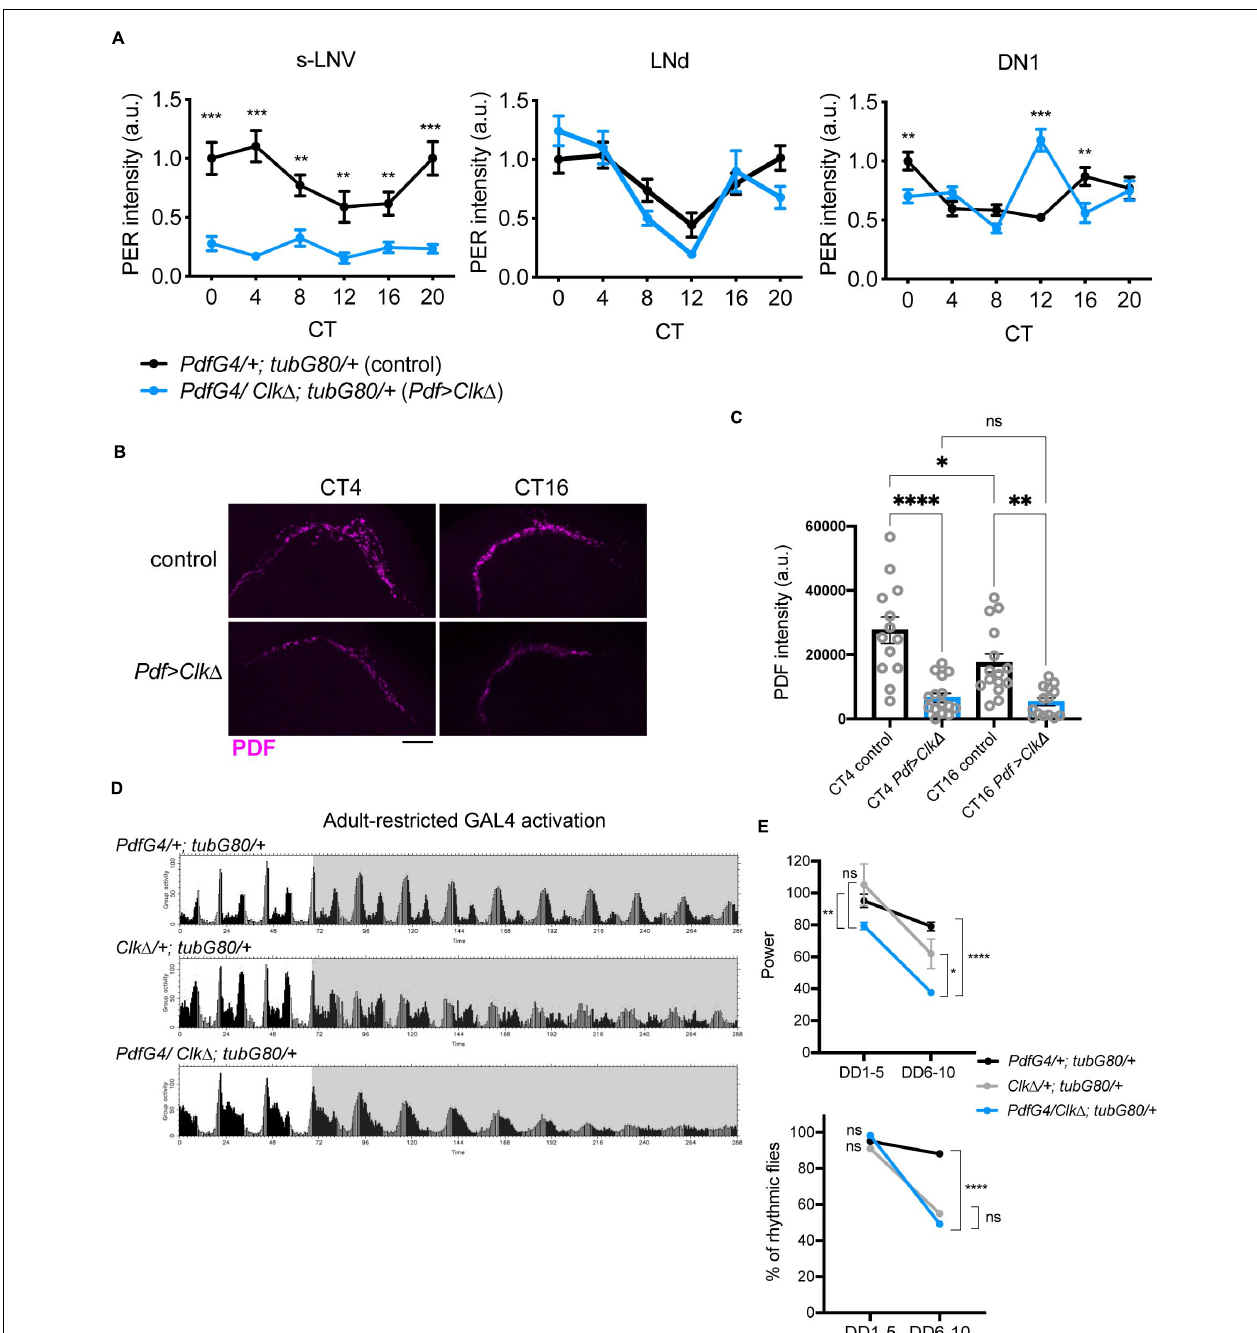
FIGURE 2 | Blocking M-oscillator clocks by conditional expression of CLK (cid:49) has little effects on free-running locomotor rhythms. UAS-Clk (cid:49) was expressed in the LNvs only during adulthood with Pdf-GAL4 , tub-GAL80 ts and a temperature shift from 18to 29 ◦ C. (A) The brains were stained for PER and PDF on DD3 and the levels of PER in the s-LNvs, DN1s and LNds were quantified. n = 20–27 hemispheres per group. ** p < 0.01, *** p < 0.001 by multiple unpaired t -test with Welch’s correction, comparing two genotypes at each timepoint. (B,C) PDF levels in the s-LNv dorsal terminals at two timepoints on DD3. Adult-restricted Clk (cid:49) in the LNvs significantly reduced PDF levels and disrupted its rhythm. Scale bar, 20 µ m. n = 12–15 per group. * p < 0.05, ** p < 0.01, and *** p < 0.00 by 2-way ANOVA with Sidak’s multiple comparison test. (D) Group average locomotor activities of the flies in LD (white background) and DD (gray background). (E) The power of rhythmicity and the percentage of rhythmic flies during the first 5 days in DD (DD1-5) and from the 6th to 10th days in DD (DD6-10) in the flies expressing Clk (cid:49) ( PdfG4/Clk (cid:49) ; tubG80/ + stands for Pdf-GAL4/UAS- Clk (cid:49) ; tub-GAL80 ts / +) and in two control groups ( PdfG4/ + ; tubG80/ + indicates Pdf-GAL4/ + ; tub-GAL80 ts / + and Clk (cid:49) / + ; tubG80/ + indicates UAS- Clk (cid:49) ; tub-GAL80 ts /+). The difference in the rhythm power was tested using the unpaired t -test with Welch’s correction and Mann-Whitney U -test * p < 0.05, ** p < 0.01, and **** p < 0.0001. The percentages of rhythmic flies were compared using Fisher’s exact test. **** p < 0.0001. ns, not significant.